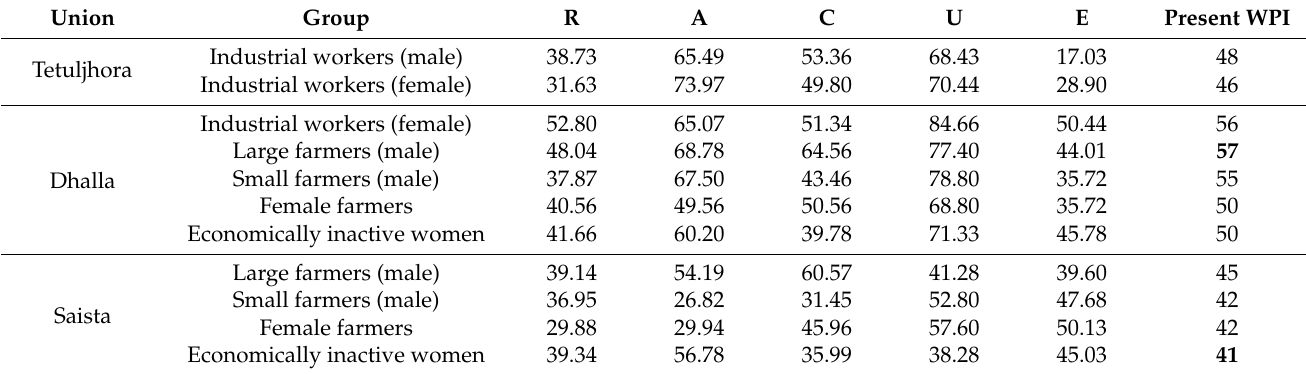
Table 4. Present WPIs for different livelihood groups in peri-urban areas around Dhaka. Union Group Present